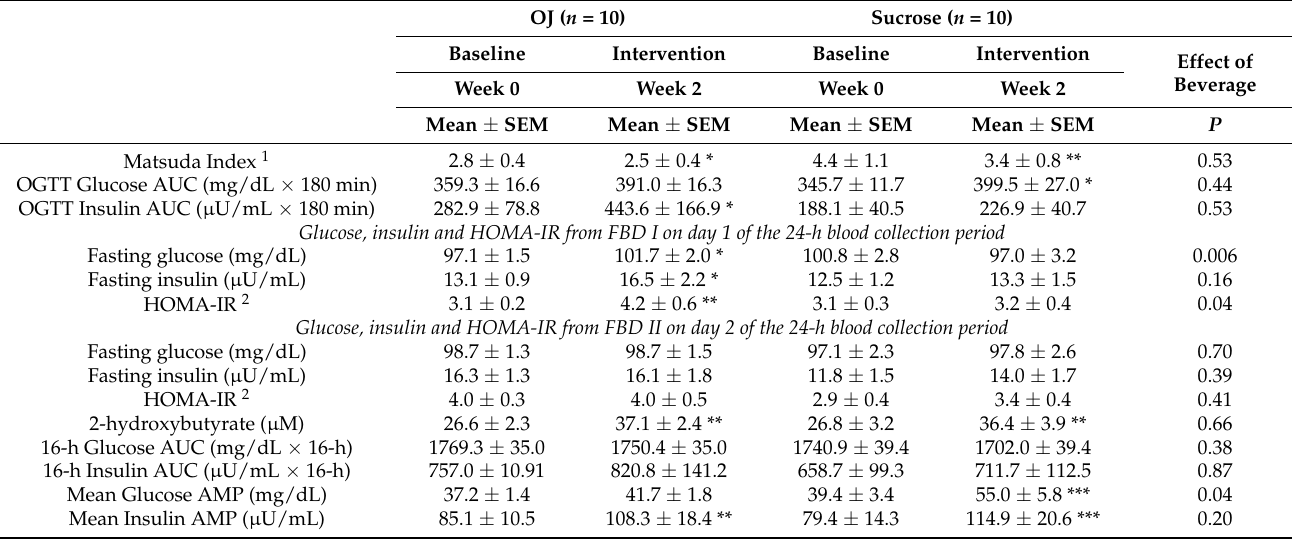
Figure 6. The 16-hour circulating glucose and insulin concentrations before (black line) and after (blue line) consumption of either ( A , C ) OJ or ( B , D ) sucrose-SB beverage for two weeks. Plasma was collected during consumption of energy-bal- anced meals at breakfast, lunch and dinner containing 55% Ereq as complex carbohydrate at baseline and during con- sumption of energy-balanced baseline diets containing 30% Ereq as complex carbohydrate and 25% as OJ or sucrose-SB at 2 weeks.